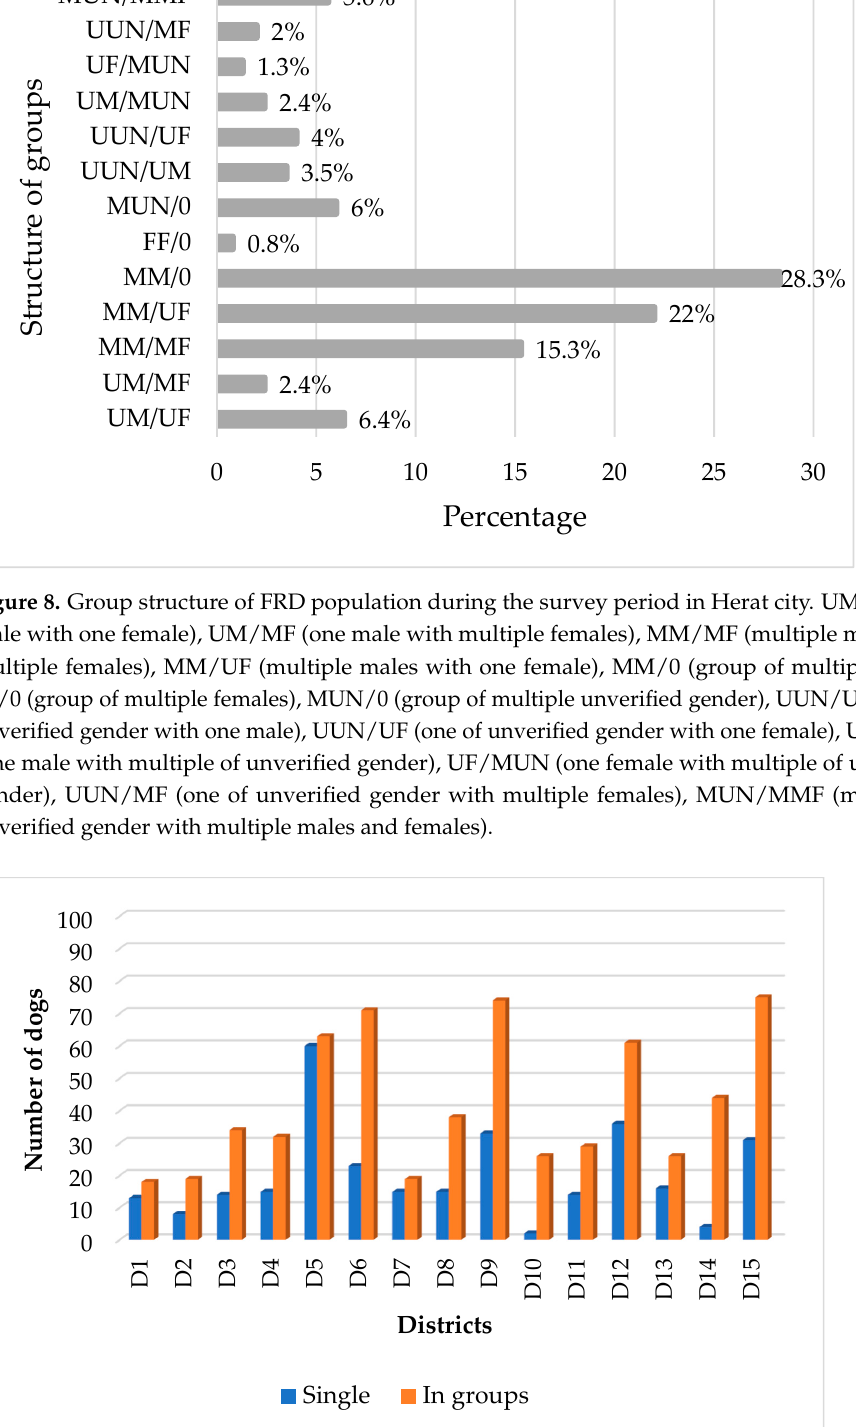
Figure 9. Social behaviour/structure of FRD population during the survey period in each district of Herat